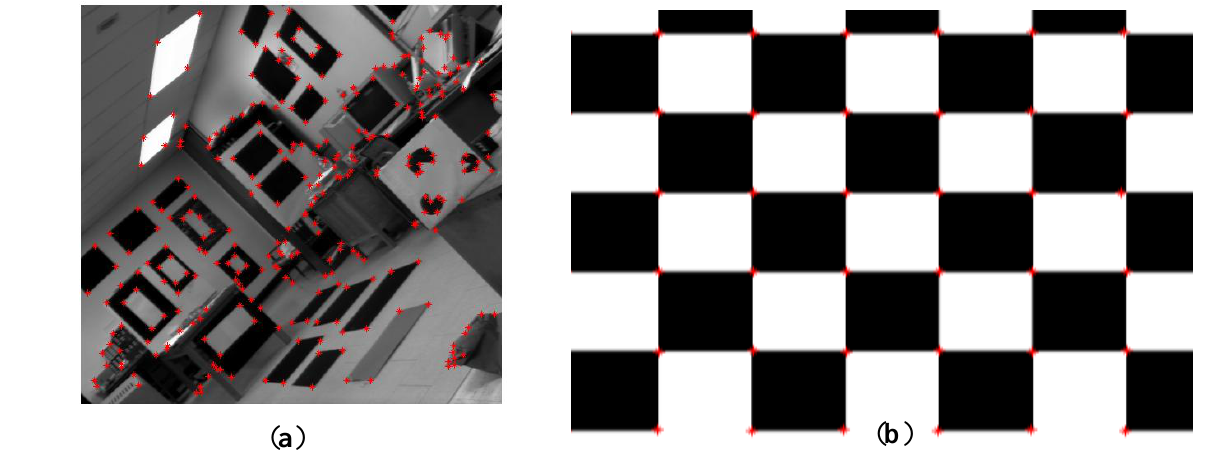
Figure 7. Corner detection results ( a ) Lab and ( b )